Question: Summarize what this figure shows in one sentence.
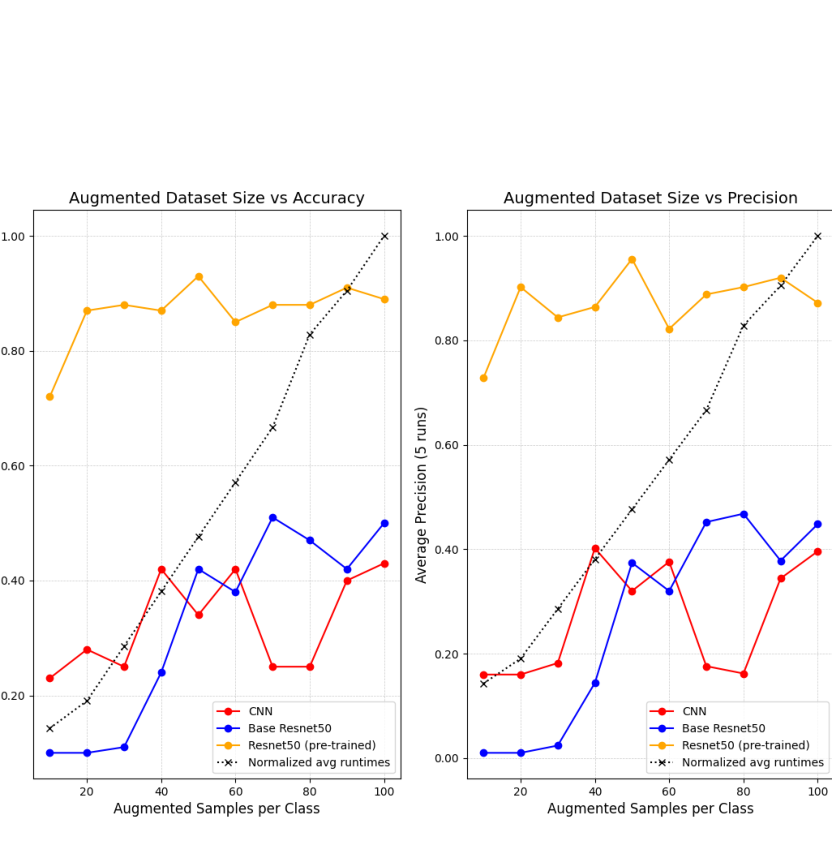
Answer: Determining the most effective size for purely augmented small microplastics data sets. The black dotted line represents averaged algorithm run-time after min-max normalization. The best performance is achieved with a pre-trained ResNet50 model using 50 augmented samples from each class. Augmentation strategy 1 was used to generate figure 2.